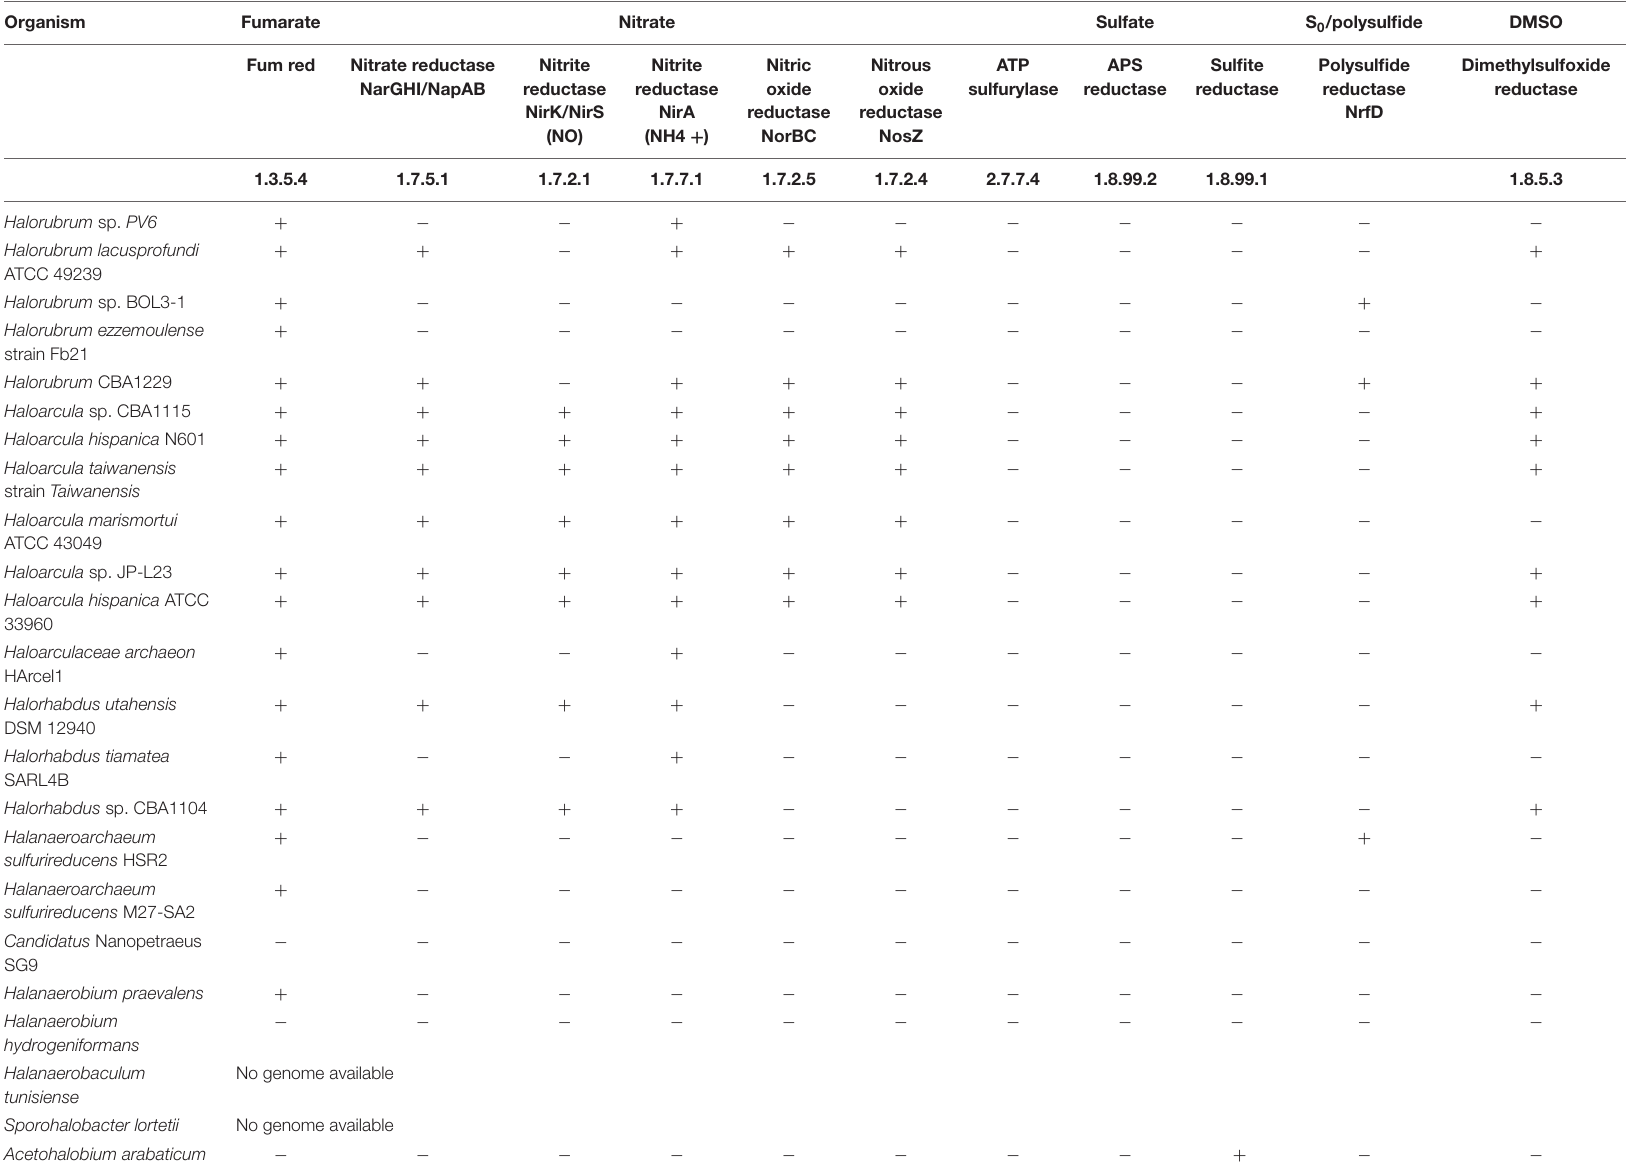
TABLE 4B | Presence or absence of genes coding for the indicated enzymes related to the utilization of the indicated electron acceptor in the genome of listed organisms.